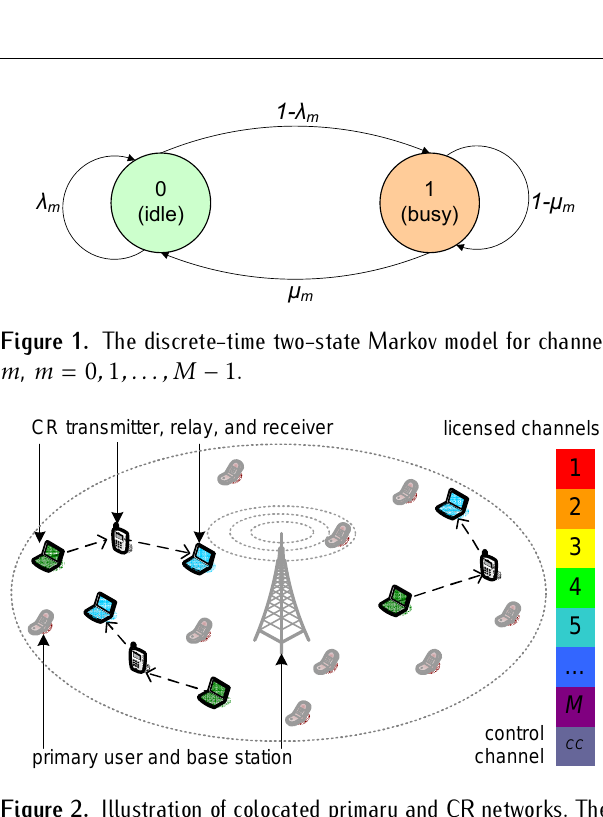
Figure 2. Illustration of colocated primary and CR networks. The CR network consists of a number cooperative relay links, each consisting of a CR transmitter, a CR relay and a CR receiver.